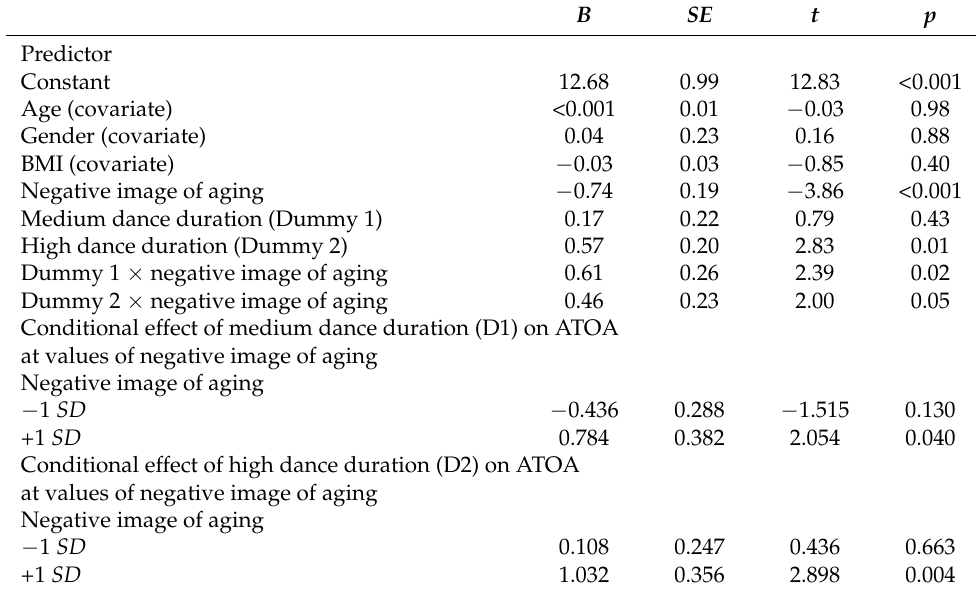
Table 2. Regression results on ATOA in model with negative image of aging.